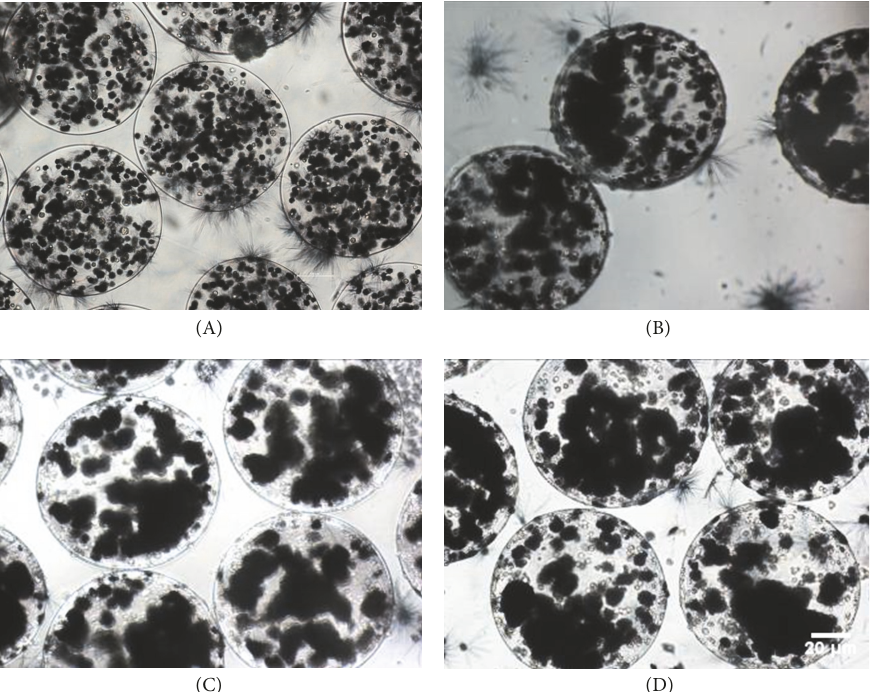
(a) Crystal formation in MTT assays in microencapsulated SGC9701 cells. The bluish-violet crystals shown in the photos were the viable cells. (A) Microencapsulated cells on day 0 as control. (B) After culturing for 7 days, some viable cells were seen in the outer layer of the spheroids and increased obviously. (C) At 14 days of culture, therewerethemostviablecellsthroughouttheculture.(D)At21daysofculture,theviablecellsslightlydecreased compared to the culture on the 14th day. Magnification: 200x